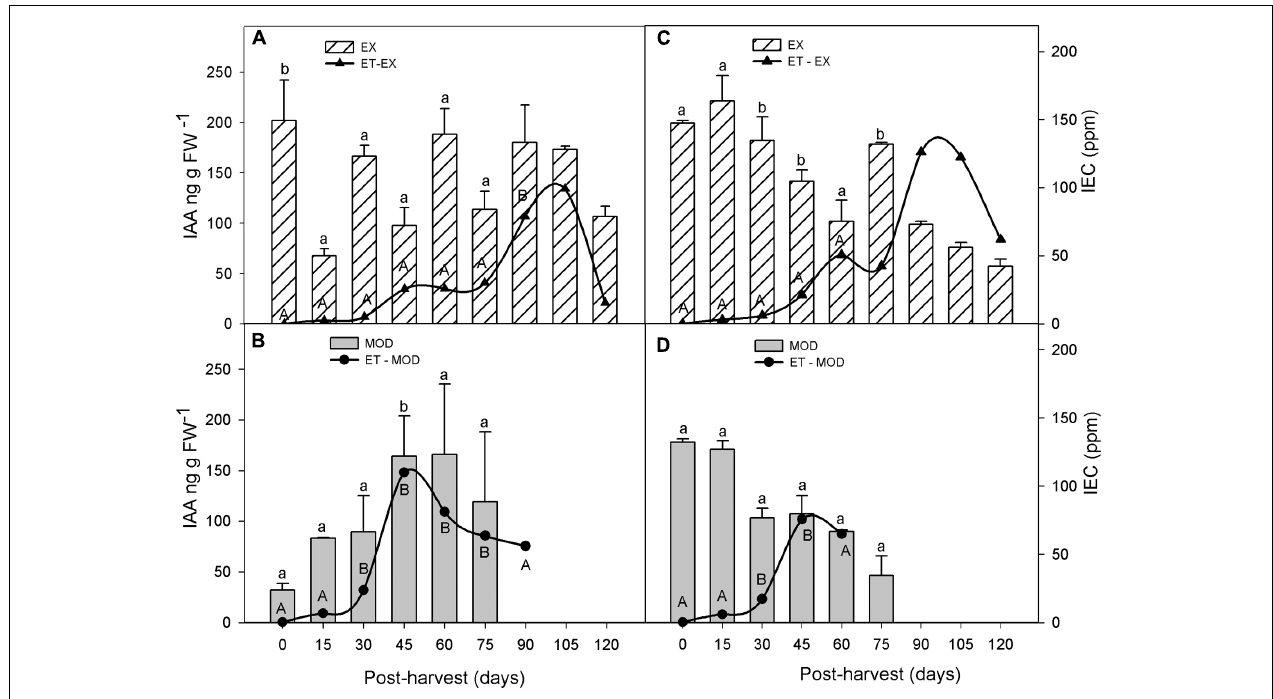
FIGURE 4 | Indol acetic acid (IAA) and ethylene (ET) evolution in apple skin during low temperature storage (0 ◦ C, > 90%RH) of exposed (EX; A,C ) and moderate sun-damaged (MOD; B,D ) fruit from orchards Quilpue (A,B) and Los Lirios (C,D) , Maule Region, Chile. Different upper-case and lower-case letters indicate statistical difference ( P ≤ 0.05) between sun damage levels ( A vs. B and C vs. D ) at each time point. Values represent means ± SE of 3 biological replicates. MOD fruit was available until 75 days into cold